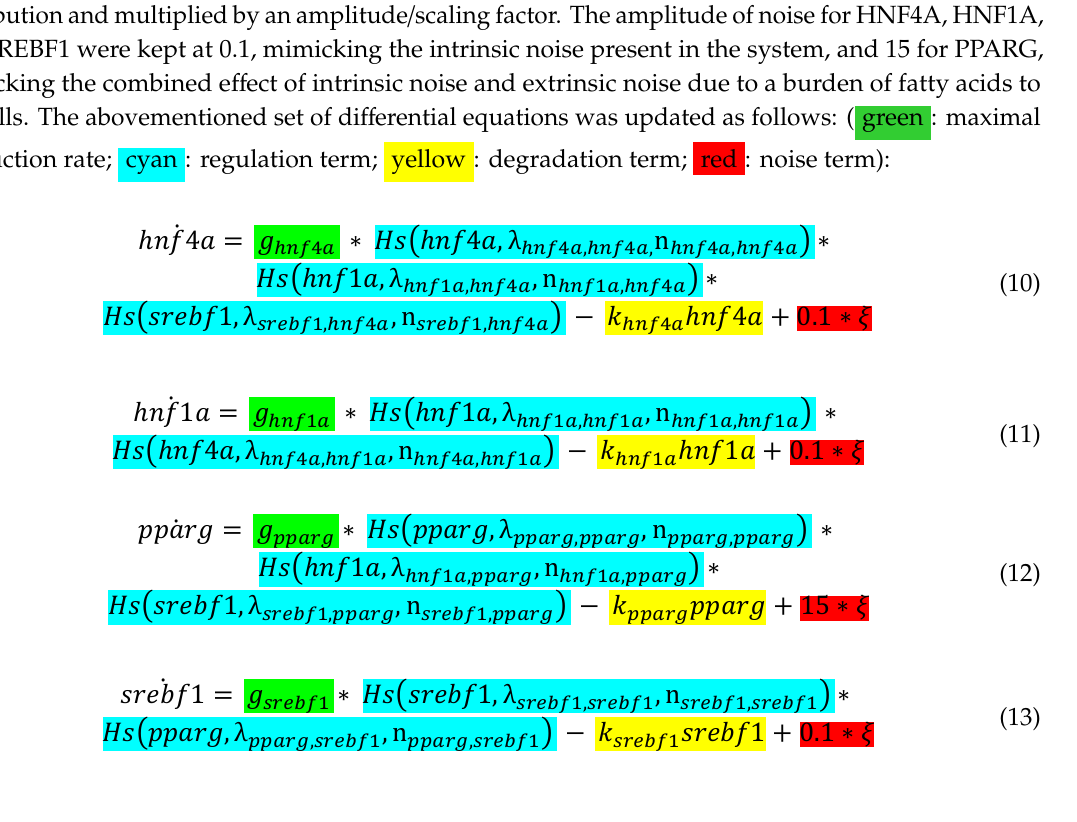
Table 2. Activation or inhibition parameters for the interaction.